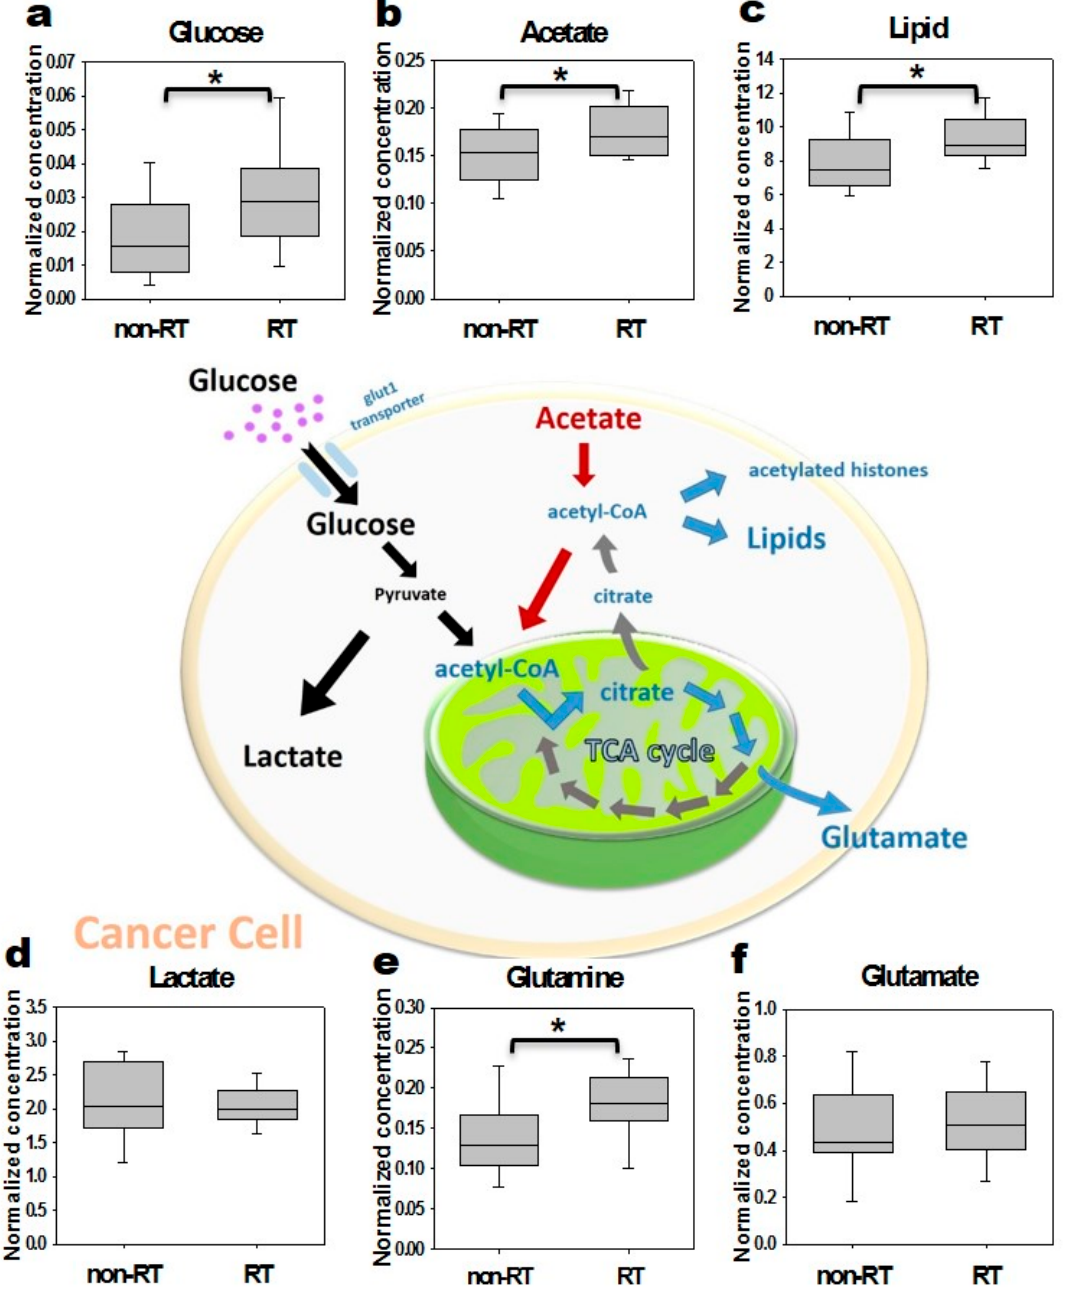
Figure 4. The aqueous and lipophilic metabolites in non-irradiated and irradiated tumors Day 3 post- irradiation in the glycolysis process based on NMR analysis. The significant increased metabolites, glucose, acetate, lipid as well as glutamine were detected in the tumors with radiation in 3 days. * p <